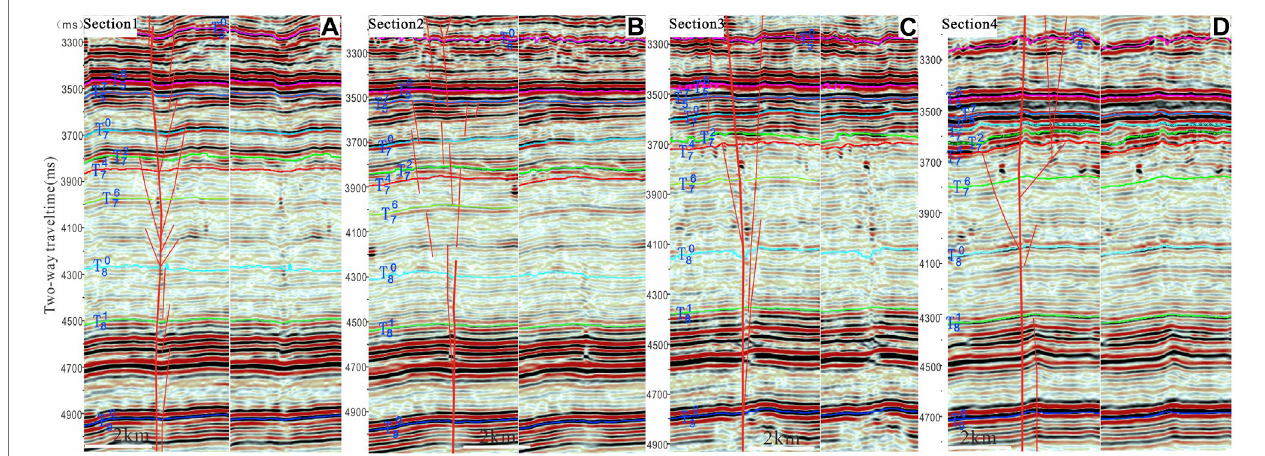
FIGURE 5 | Fault interpretations of cross sections 1 – 4 oriented perpendicularly to fault TP12CX. (A) Section 1. (B) Section 2. (C) Section 3. (D) Section 4. (A – D) Theuninterpretedrightimagesareshownforcomparisonandcroppedasthecentralpartoftheleftimageswherefaultzonesoccur;see Figure4 forthelocationsofthe sections.